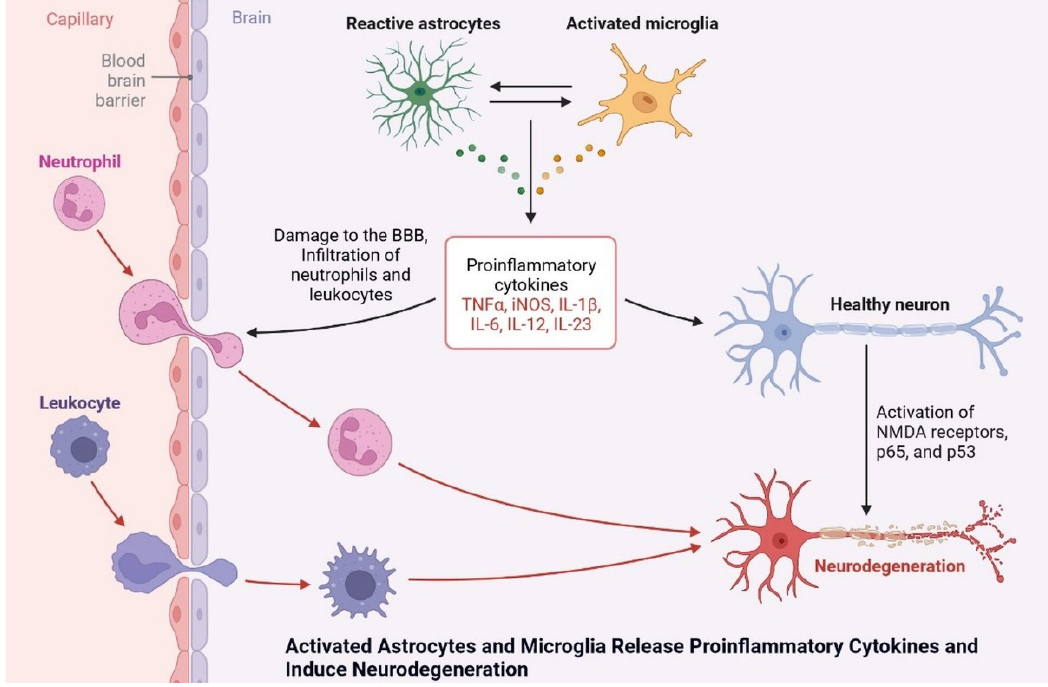
Figure 13. Activated astrocytes and microglia release proinflammatory cytokines and induce neu- rodegeneration.